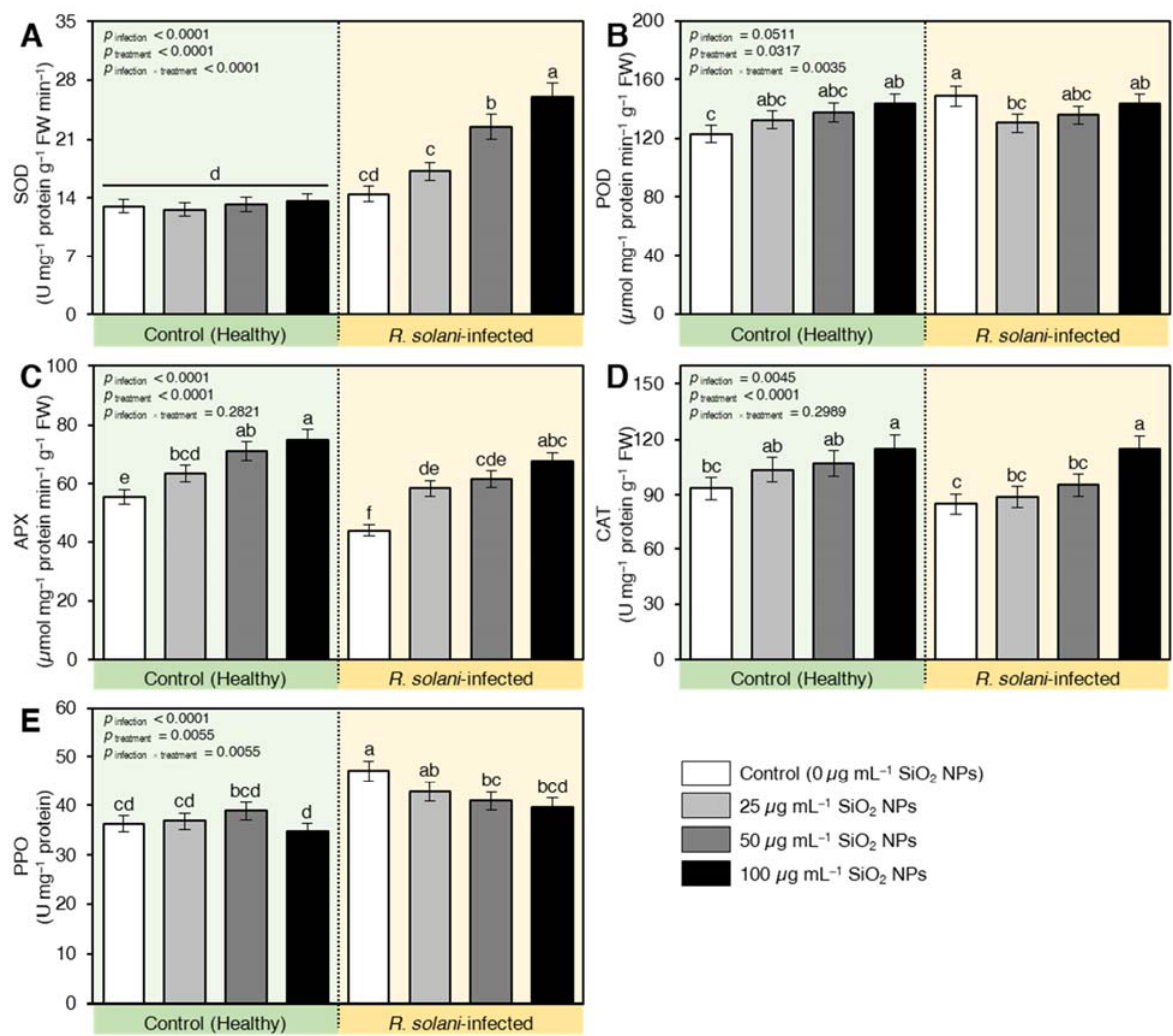
Figure 10. Effect of silicon dioxide nanoparticles (SiO 2 NPs) on enzymatic antioxidant machinery of R. solani -infected seedlings. ( A ) Superoxide dismutase (SOD), ( B ) Guaiacol peroxidase (POD), ( C ) Ascorbate peroxidase (APX), ( D ) Catalase (CAT), and ( E ) Polyphenol oxidase (PPO). Data presented are means ± standard deviation (mean ± SD) of five biological replicates. Different letters indicate statistically significant differences among treatments, while the same letters signify no significant differences between them according to Tukey’s honestly significant difference test ( p < 0.05).